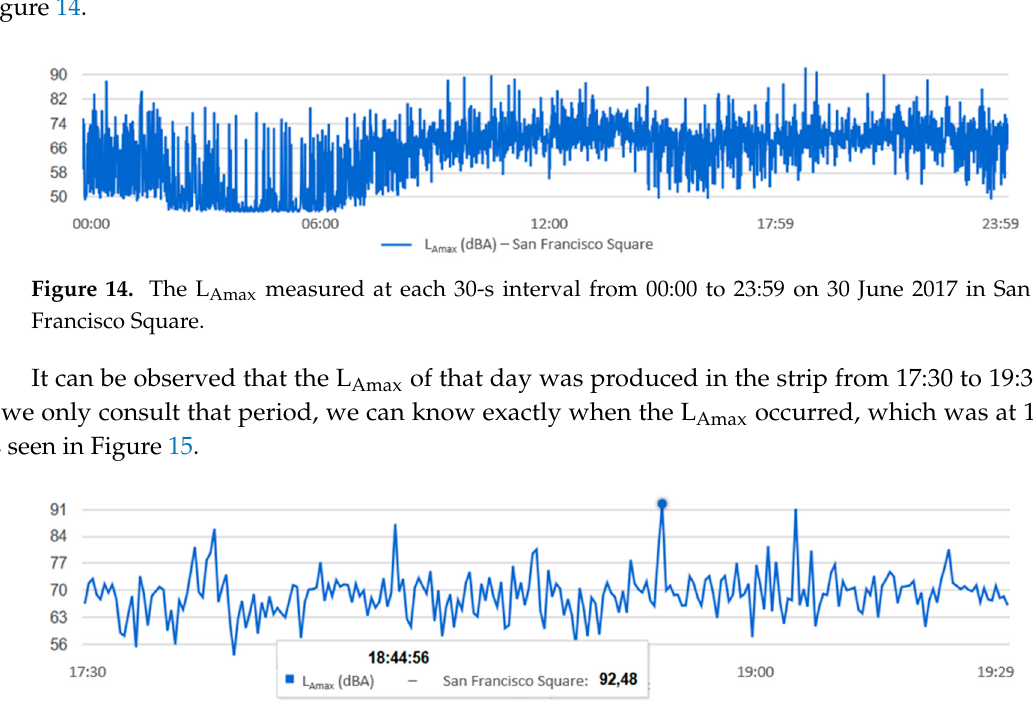
Figure 13. The temporal evolution of the noise in Andalucia Avenue location for a full week in the month of October.